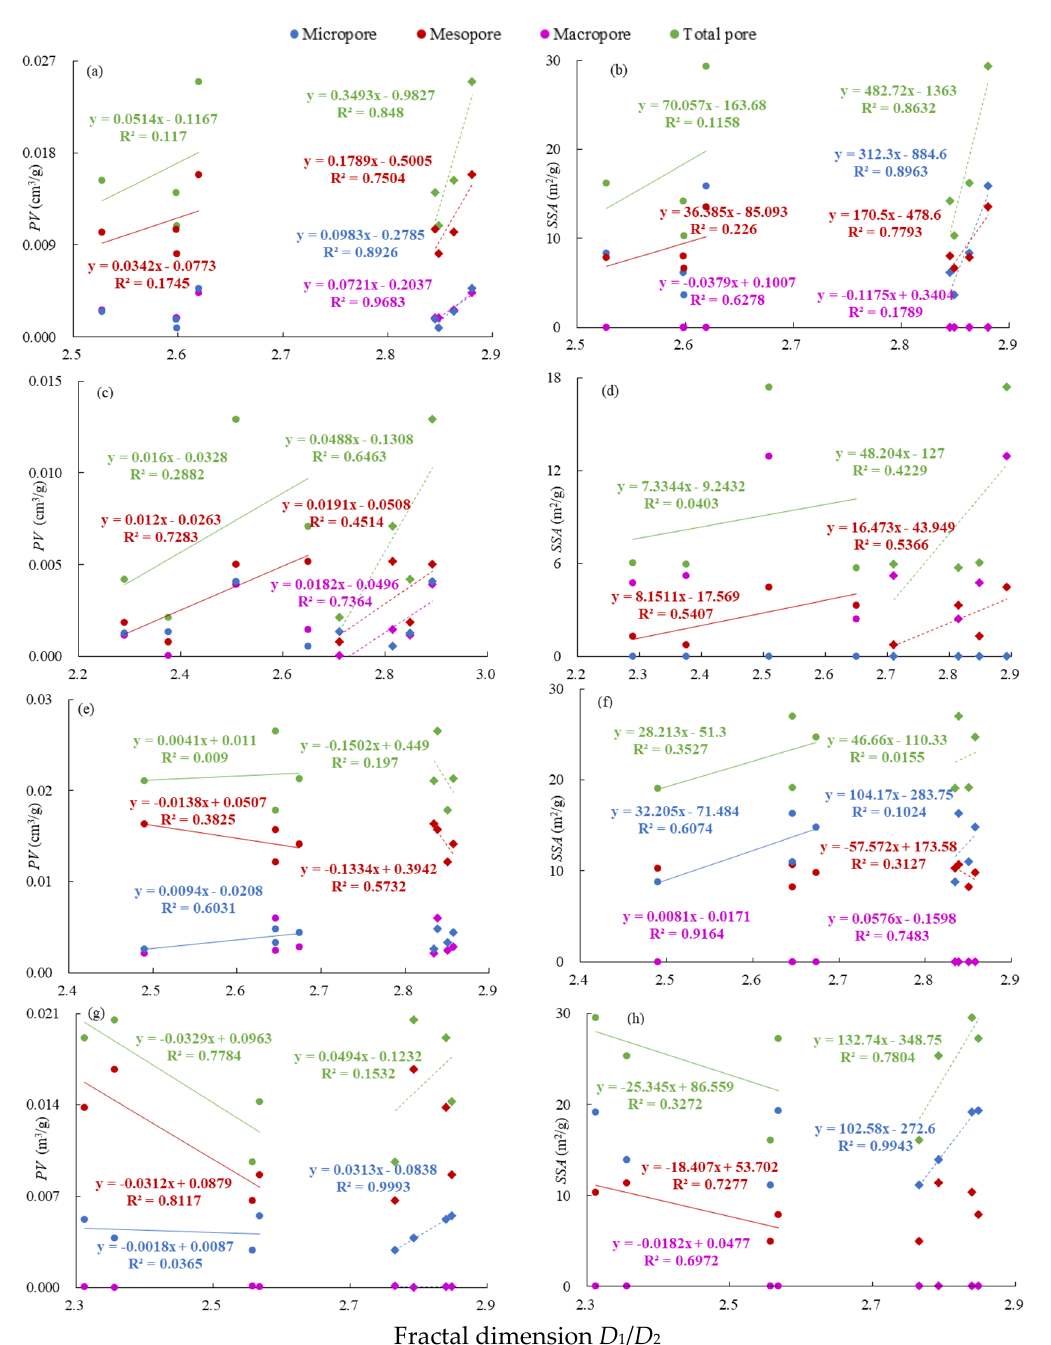
Figure 17. Relationships between D 1 / D 2 and pore structure parameter (( a , b ) Longmaxi Fm in southern Sichuan Basin. ( c , d ) Qiongzhusi Fm in southern Sichuan Basin. ( e , f ) Longmaxi Fm in northern Guizhou province. ( g , h ) Niutitang Fm in northern Guizhou province).